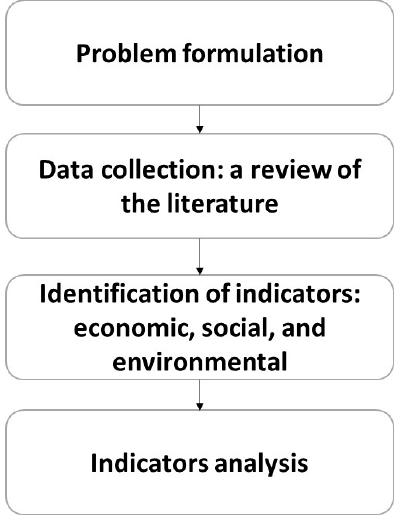
Figure 2. Methodology steps. Source: